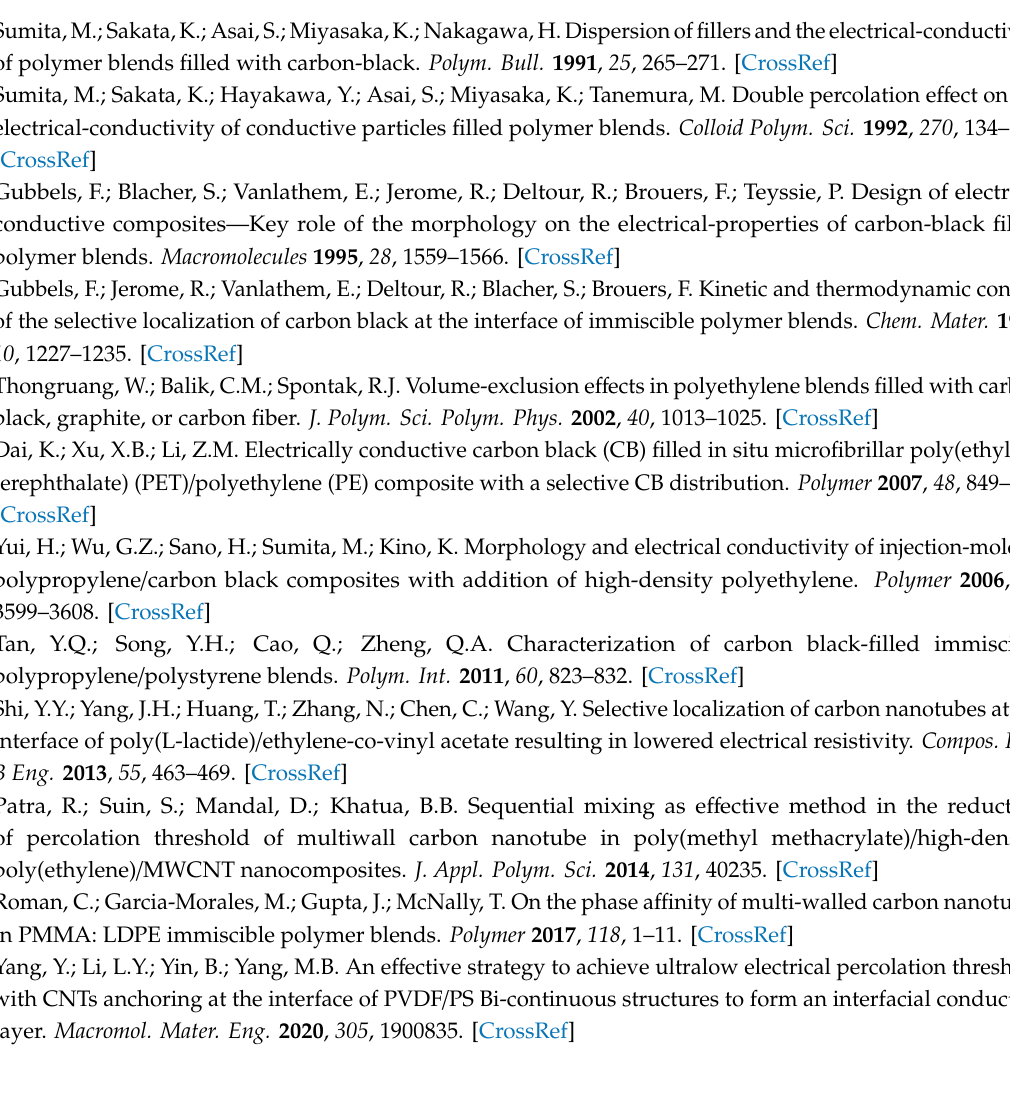
Figure S1: The SFM phase images of P3HT nanofiber composited in (a) PB and (b) PEG matrix (20 µ m × 20 µ m). From the images, P3HT nanofibers were uniformly dispersed in PB matrix while nanofibers aggregated each other in PEG matrix., Figure S2: Optical microscope images of a substrate with electrodes for measuring conductivity and estimating the field-e ff ect mobility, Figure S3: Temperature dependence of the transfer characteristics of the PB / PEG blend film loaded with P3HT nanofiber with ϕ PB = 0.72 ( > ϕ cI) from 60 K to 300 K, Table S3: The spacing between the electrodes L, the width of the electrodes W, and the capacitance of the insulation layer of SiO 2 (255-nm thick)